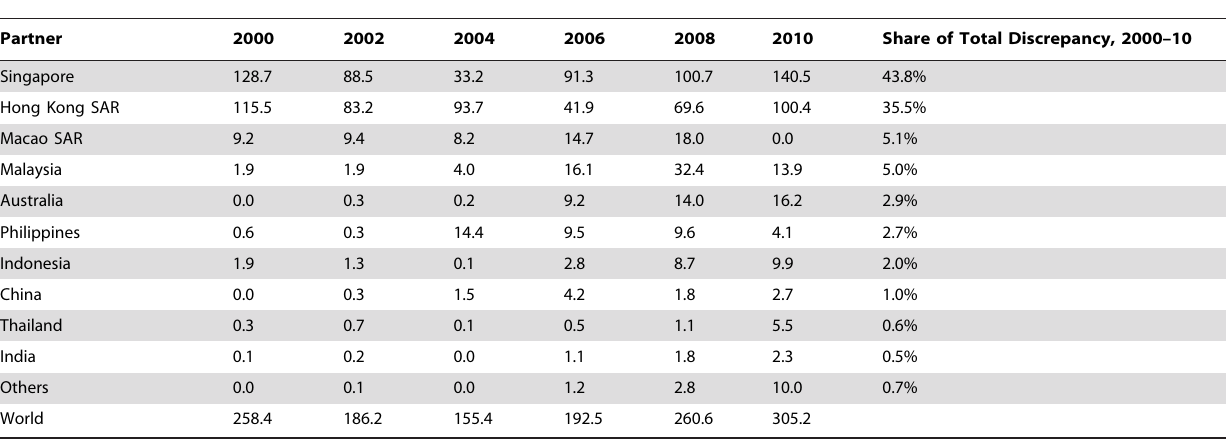
Table 4. Net Smuggling into Vietnam among Ten Largest Sources for Smuggling, 2000–2010 (millions of US dollars).